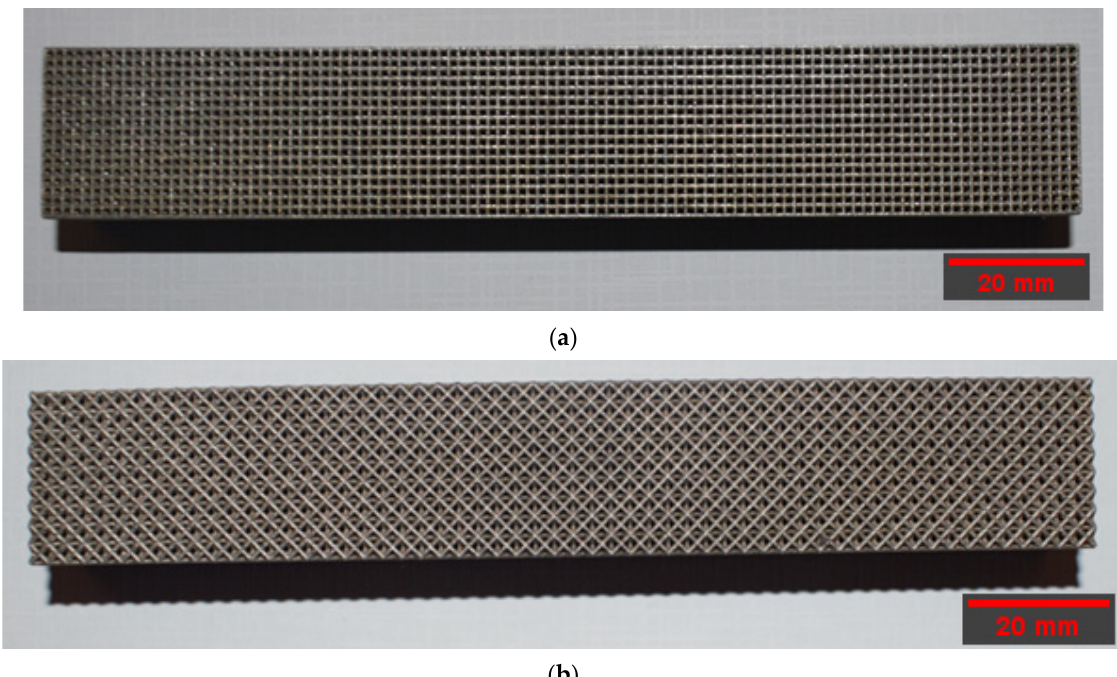
Figure 2. Beam specimens: ( a ) cubic, ( b ) diagonal.